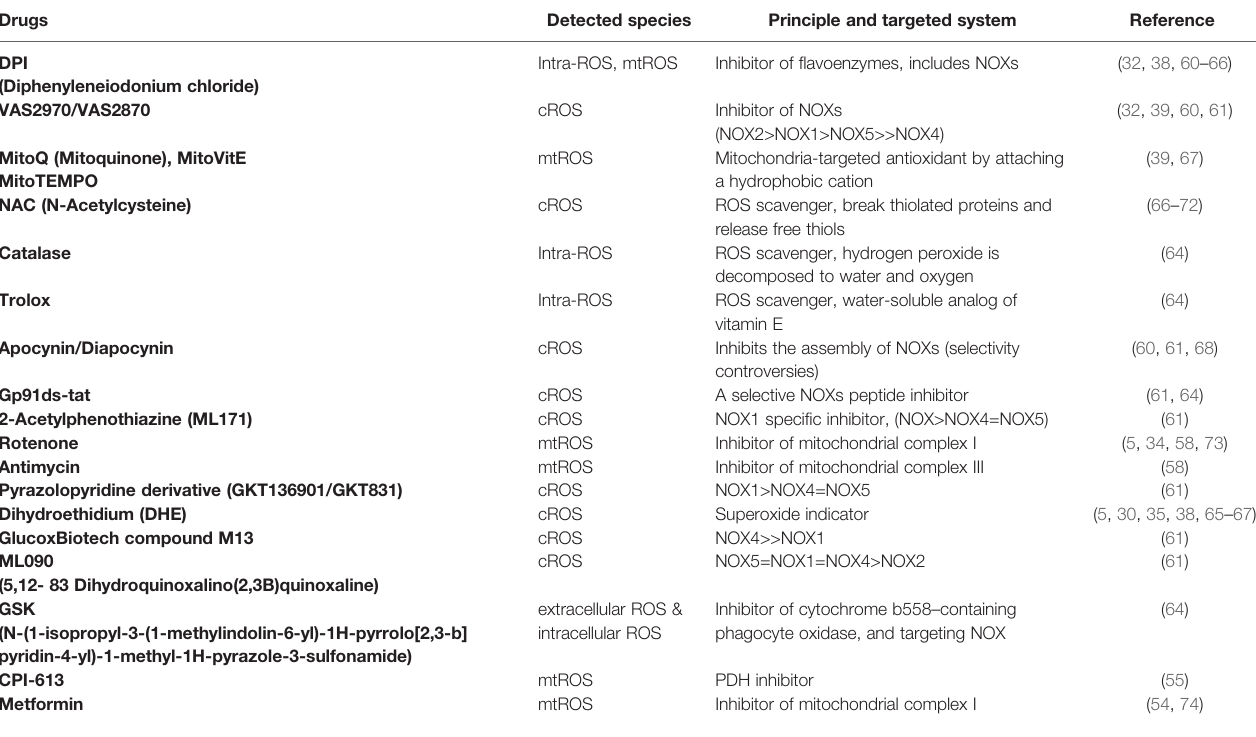
TABLE 1 | Inhibitory compounds targeting mtROS and cytosolic ROS (cROS) in the